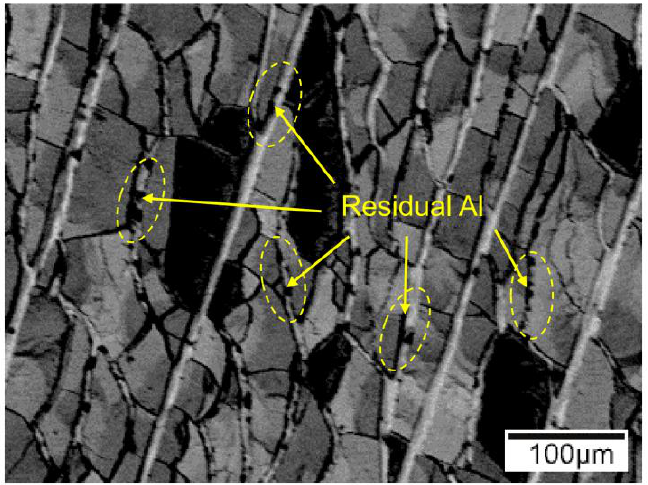
Figure 10. Peeling surface morphology (BSE image) of the Cu/Al clad sheet with a thickness of 5 mm after multi-pass rolling (Cu side).